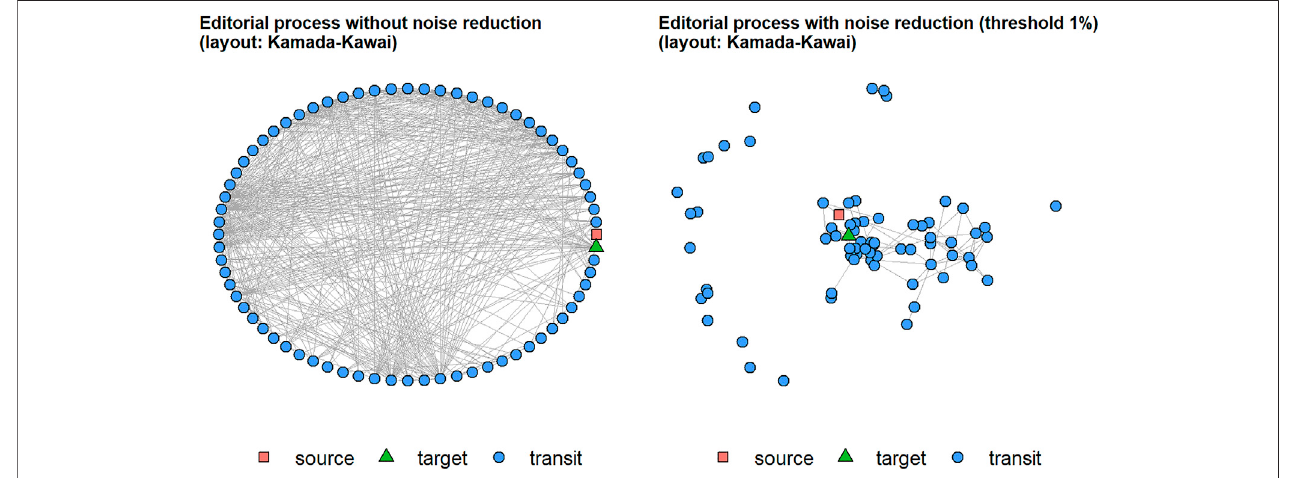
FIGURE 4 | Order of the process without and with noise reduction. After noise-reduction, a core component emerges.